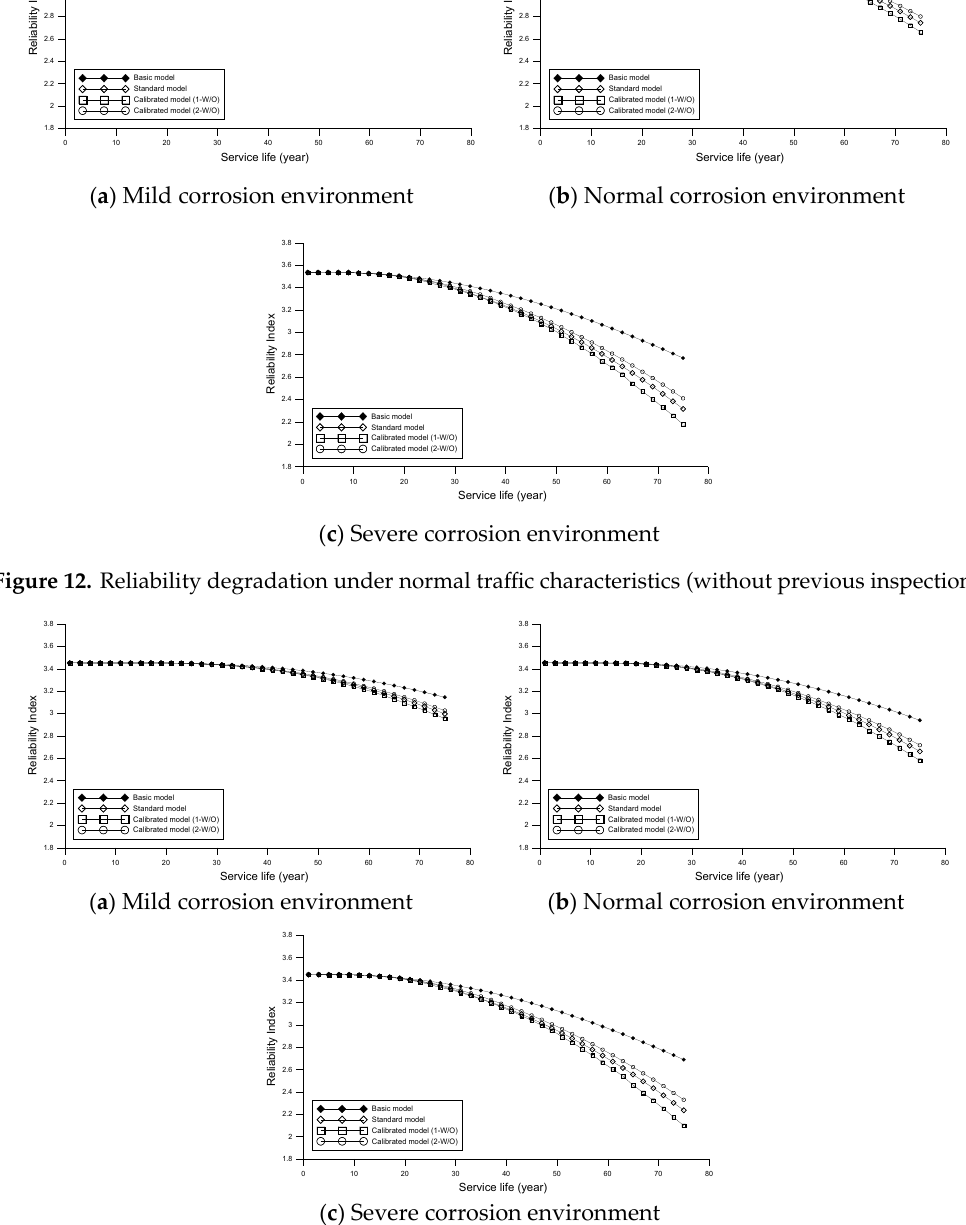
Figure 13. Reliability degradation under heavy traffic characteristics (without previous inspection).